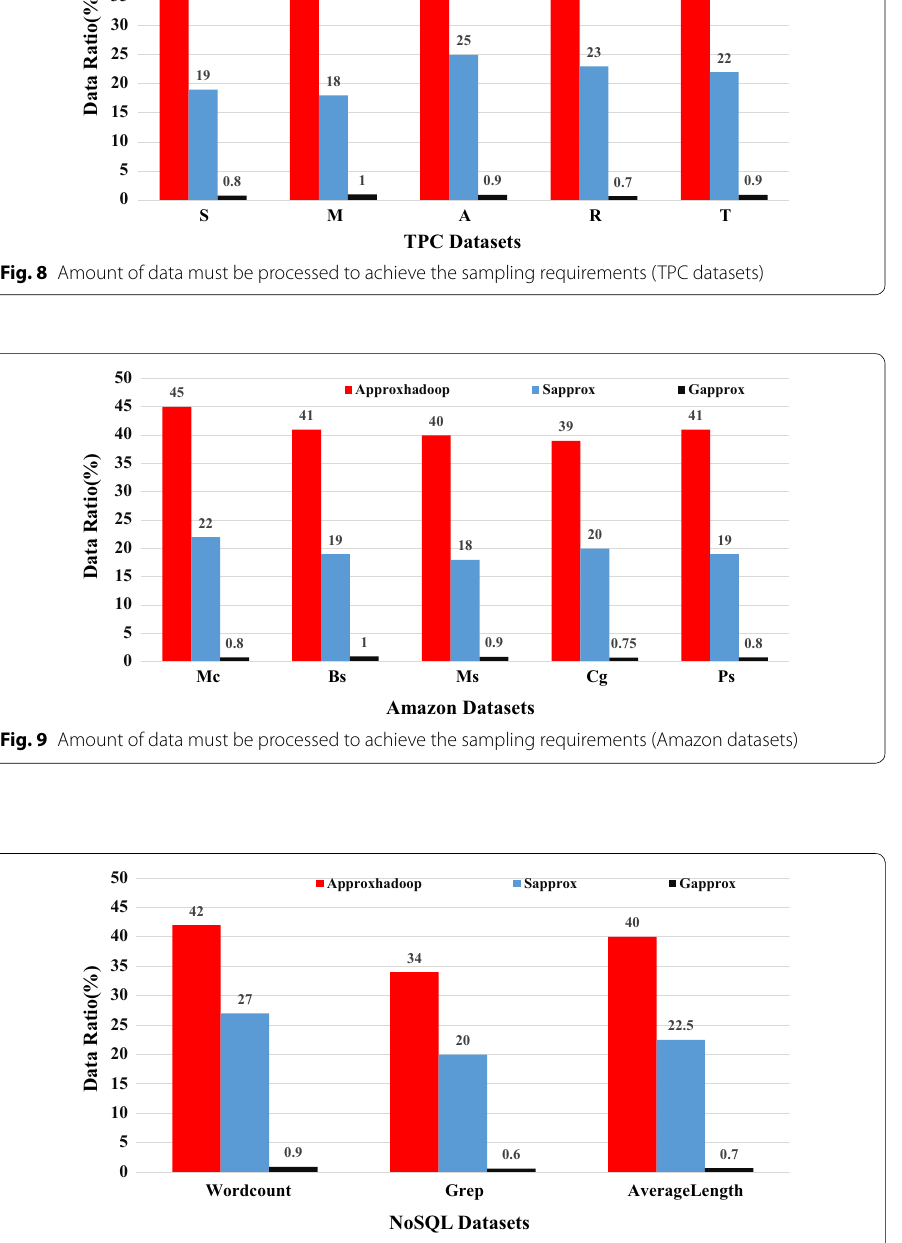
Fig. 10 Amount of data must be processed to achieve the sampling requirements (NoSQL